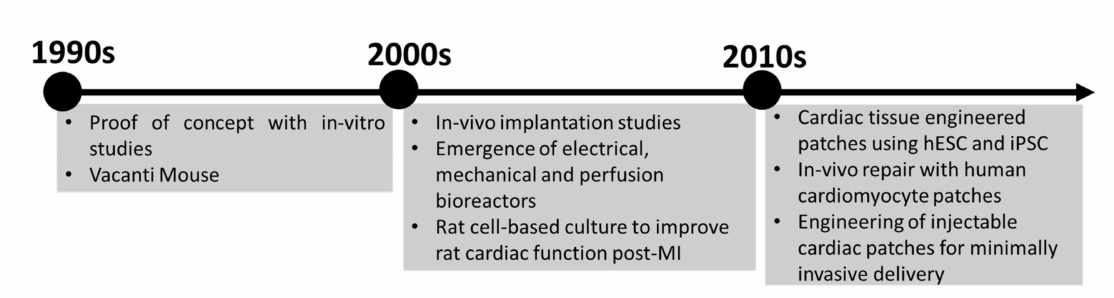
Figure 6. Brief history of TE products leading up to cardiac patches conceptualisation. Adapted from